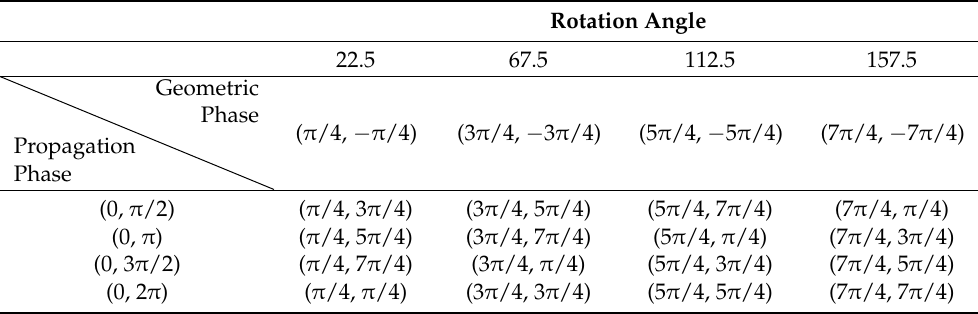
Table 2. The phase groups in 1/2 intensity under LCP light and RCP light.